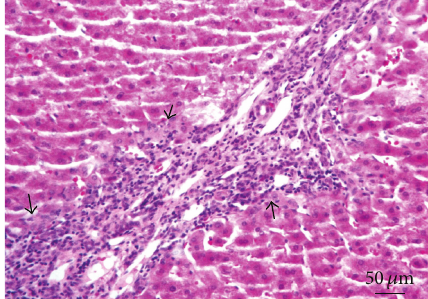
Figure 9: Liver. Lesion Grade II. Moderate nonsuppurative peripor- tal interstitial inflammatory response (arrows). Hematoxylin and eosin.